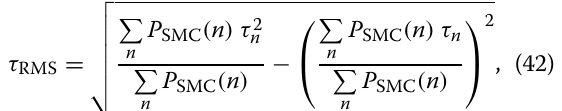
and τ RMS can be calculated from the SMC power